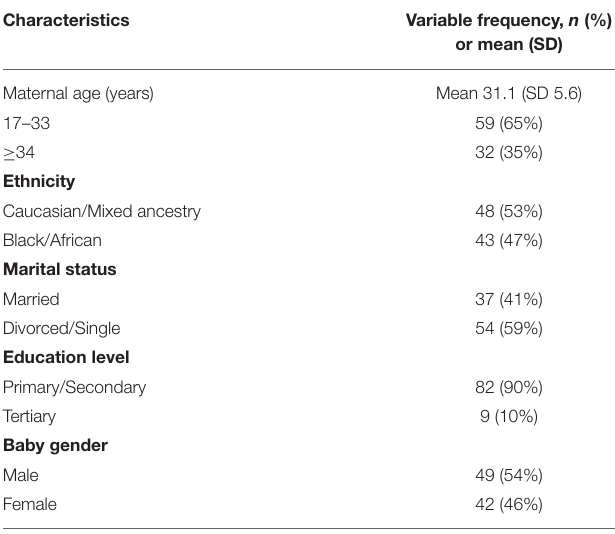
TABLE 1 | Demographic * and clinical characteristics of mothers ( n = 91) of babies at age 6 months.